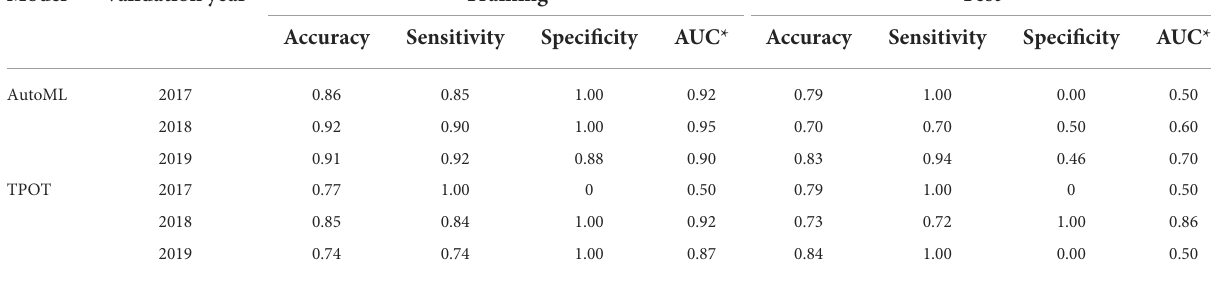
TABLE 6 Results for the auto ML models by year. Model